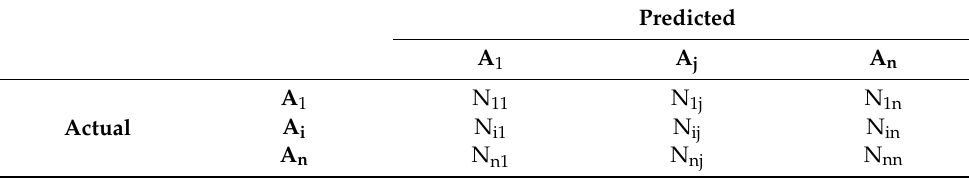
Table 7. Multi-label confusion